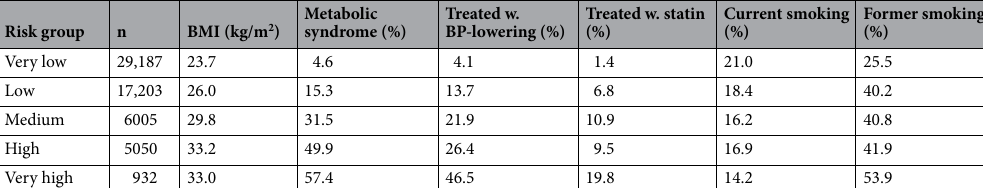
Table 5. Association between risk classification according to Model 2 and existing cardiovascular risk factors. Diagnosis of metabolic syndrome is based on the revised National Cholesterol Education Program criteria from 2004 by the American Heart Association (19). Diagnosis is established if at least three out of five criteria are met: (1) SBP ≥ 130 mmHg and/or DBP ≥ 85 mmHg and/or use of antihypertensive medication;